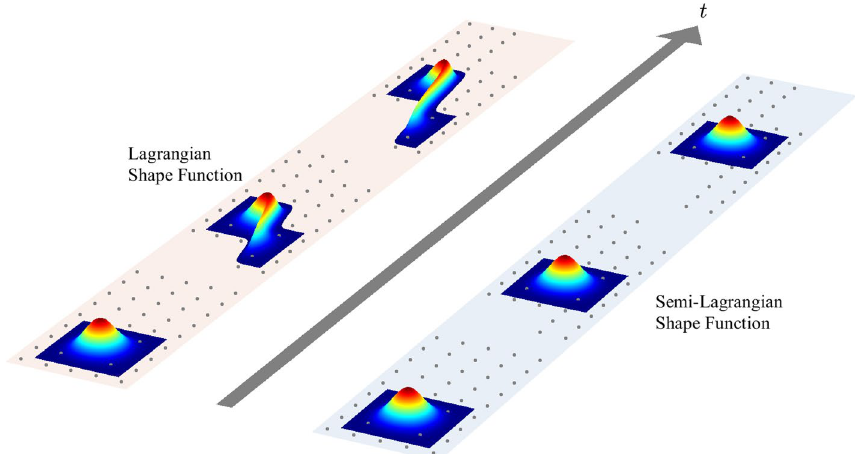
Fig. 3 Lagrangian and semi‑Lagrangian shape functions under shear localization. The shape functions are plotted only on their kernel support. The gray points denote nodal